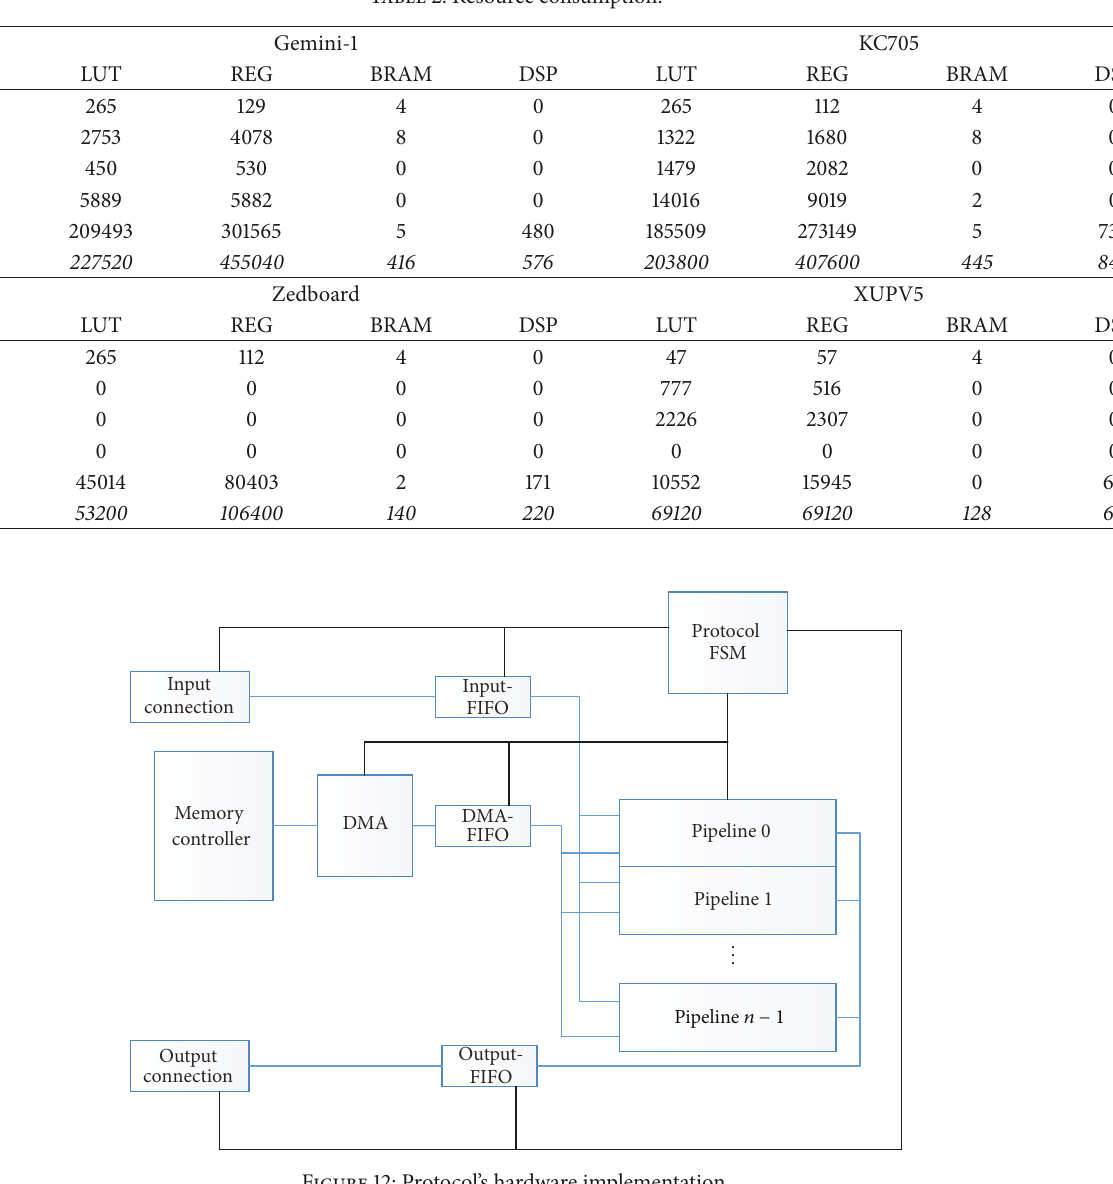
Table 2: Resource consumption.